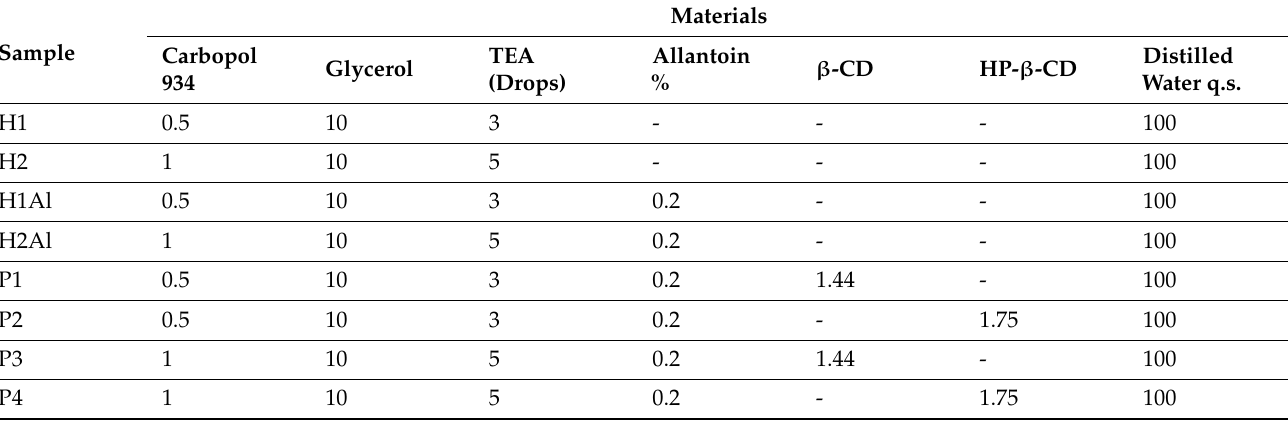
Table 1. Composition of the bioadhesive